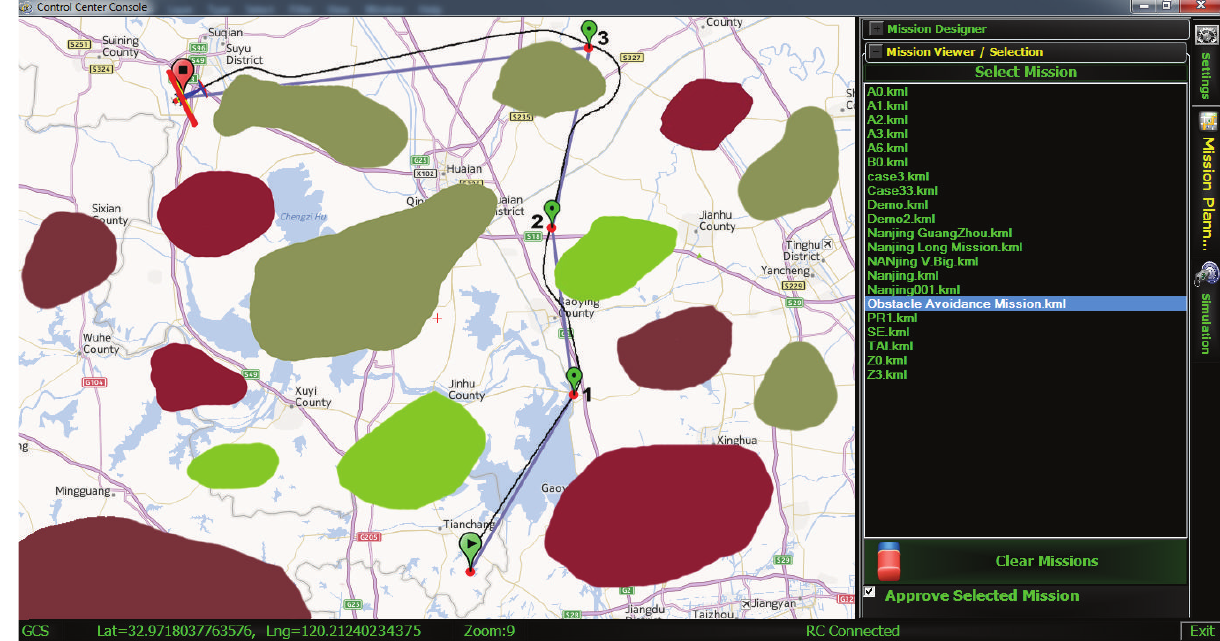
Figure 12: Proposed hybrid simulator for an obstacle avoidance